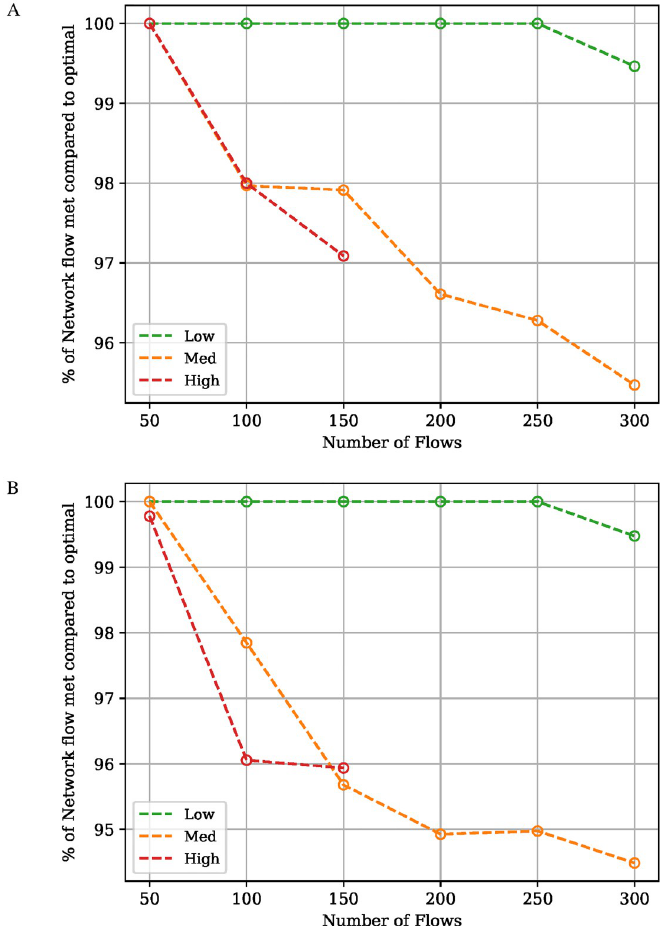
Fig 7. Comparison of demand reached between ERA and PC-MFMC. Plot illustrating the Percentage of demand achieved by the ERA algorithms when compared to the optimal solution to the PC-MFMC problem solved using LP. The solution with the largest network flow found by the ERA is used. A: Path Selection Algorithm: KSP. B: Path Selection Algorithm: